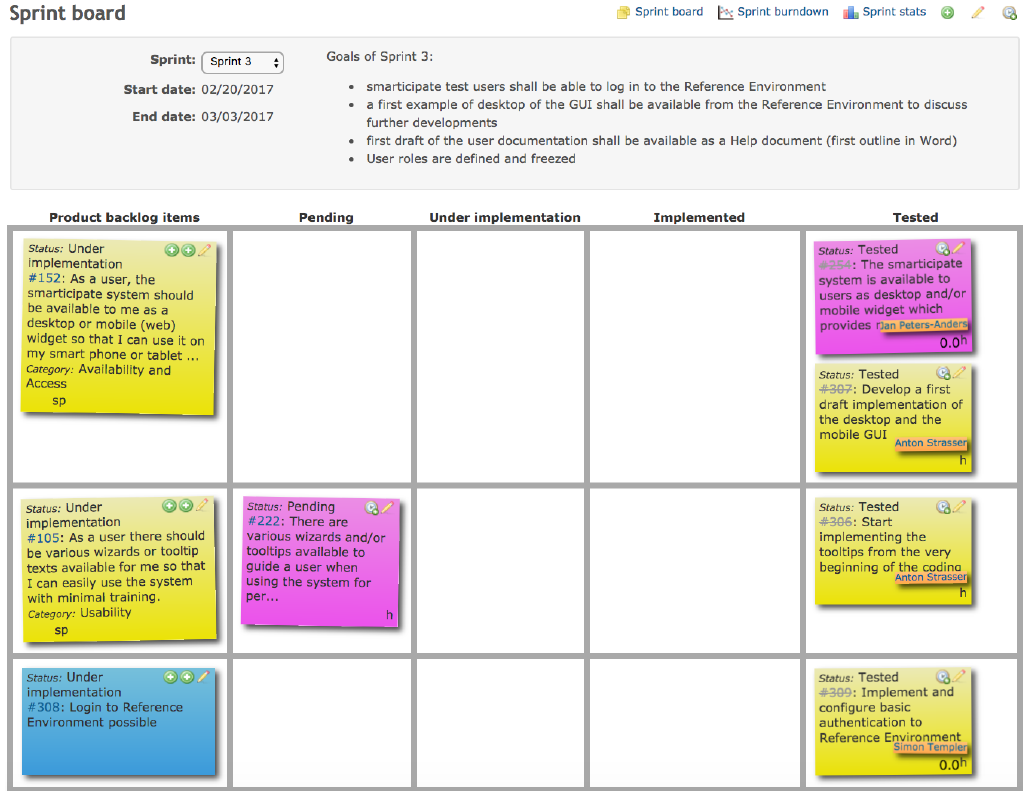
Figure 5. Sprint board—SCRUM sprint planning (colouring scheme shows different categories of items e.g., yellow colours are features, blue colours are technical tasks, purple colours are test cases).